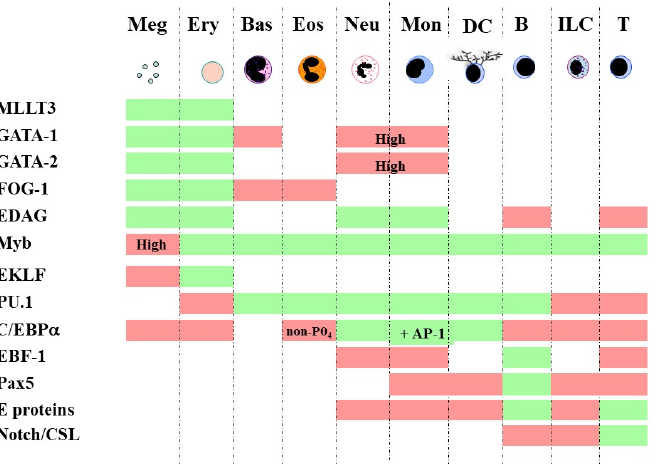
Figure 1. Shared usage of TFs by contiguous fates. The coordinated activity of multiple TFs is important to whether a cell adopts or avoids a particular fate. TFs can promote the development of one cell type or set of adjacent cell types and suppress neighboring fates. Boxes that are shaded green show that TFs must be active to direct the development of the particular cell type, and the TF inhibits the adoption of a fate for boxes that are shaded red (reviewed in [57]). Meg, megakaryocyte; Ery, erythroid; Bas, basophil/mast cell; Eos, eosinophil; Neu, neutrophil; Mon, monocyte; DC, dendritic cell; B, B cell; ILC, innate lymphoid cell; T, T cell.